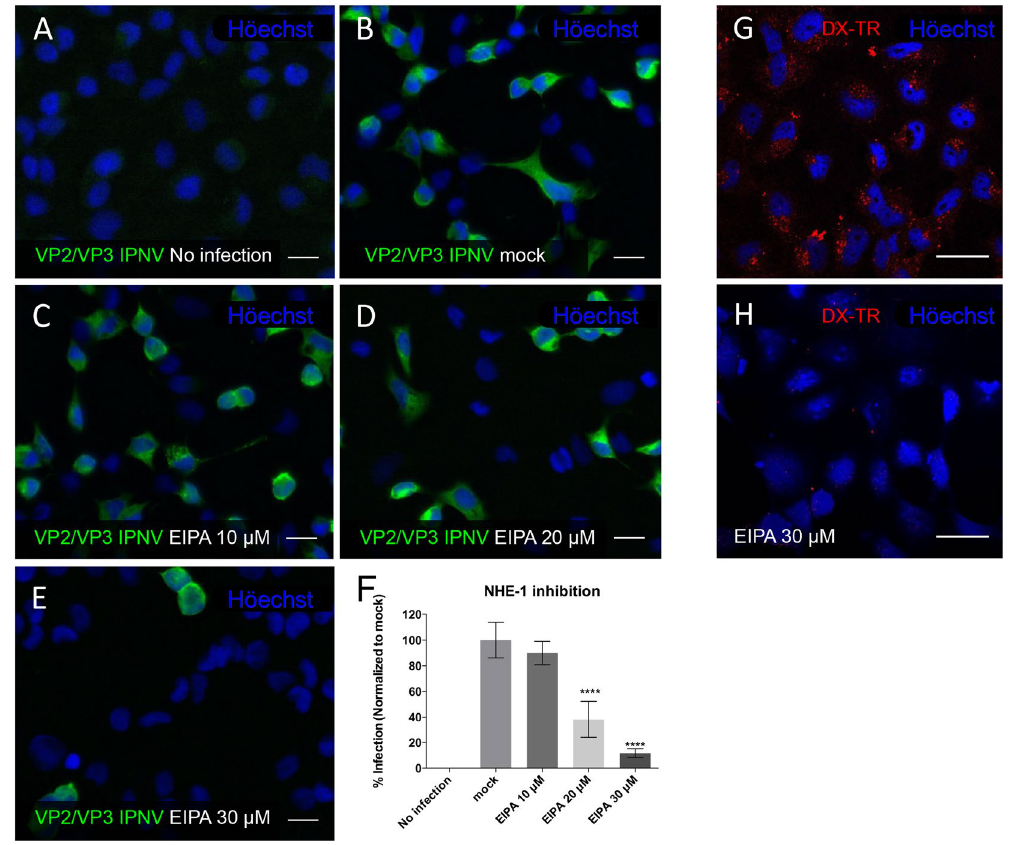
Figure 7. IPNV infection of CHSE-214 cells is blocked by EIPA. CHSE-214 cells were propagated to 70–80% confluence in 24-well plates with round glass coverslips and infected with IPNV at a MOI of 1 for 1 h in the presence of 0 ( B ), 10 ( C ), 20 ( D ), 30 ( E ) µ M EIPA. No infection ( A ). After 12 h of incubation at 20 °C, cells were processed by indirect immunofluorescence (IFI). Representative images recorded with an Olympus Spinning Disk IX81 microscope are shown (bar scale = 20 µ m). For quantification, 250 cells were counted at each condition and the number of VP2/VP3-expressing cells are shown as a percentage, normalized to mock cells ( F ) ( **** p < 0.0001). Control CHSE-214 cells pre-incubated for 1 h in the presence ( H ) or absence ( G ) of 30 µ M EIPA and 1 mg/ml of Dx-Texas Red 70 kDa (Dx-TR) were added. After 30 min of incubation, cells were washed, fixed with 3.7% PFA-4% sucrose for 30 min and stained with Höechst solution. Images were recorded with a C2 Plus Eclipse TI Nikon confocal microscope. Representative images are shown (bar scale = 20 µ